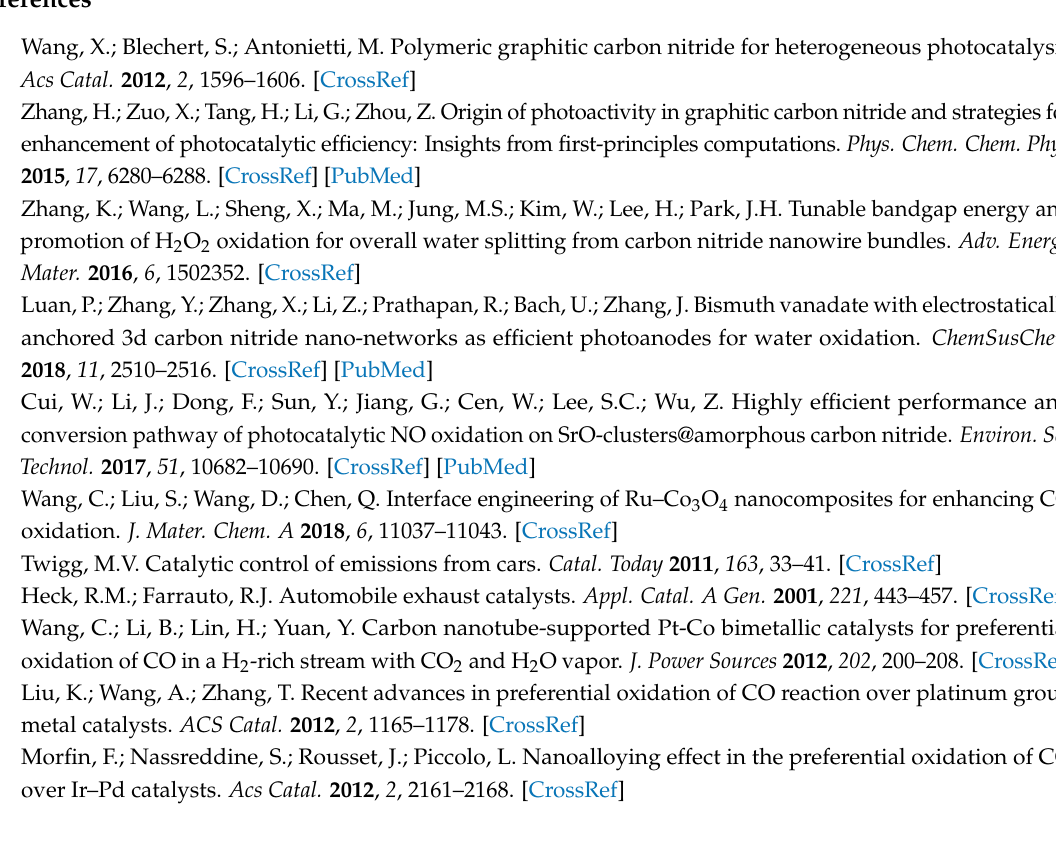
Figure S1: (a) SEM image and (b) TEM image of metal free CN NWs, Figure S2: FTIR spectrum of Pd/Cu/CN NWs and CN NWs, Figure S3: TEM images of Pd/Cu CN NWs obtained by (a) quick addition of melamine, (b) quick addition of HNO3, (c) using 60 mL of HNO3 (0.05 M), (d) using 60 mL of HNO3 (0.15 M), Figure S4: (a) the CO conversion efficiency on the as-synthesized catalysts at temperature ranging between 25 and 200 ◦ C, (b) the complete conversion temperature T100, Figure S5: The CO 2 produced relative to CO consumed during the CO oxidation reaction, Figure S6: TEM image of Pd/Cu CN NWs before (a) and after (b) stability tests, Table S1: Comparison between the CO oxidation activity of our newly designed Pd/Cu/CN NWs and various Pd-based and Cu-based catalyst reported